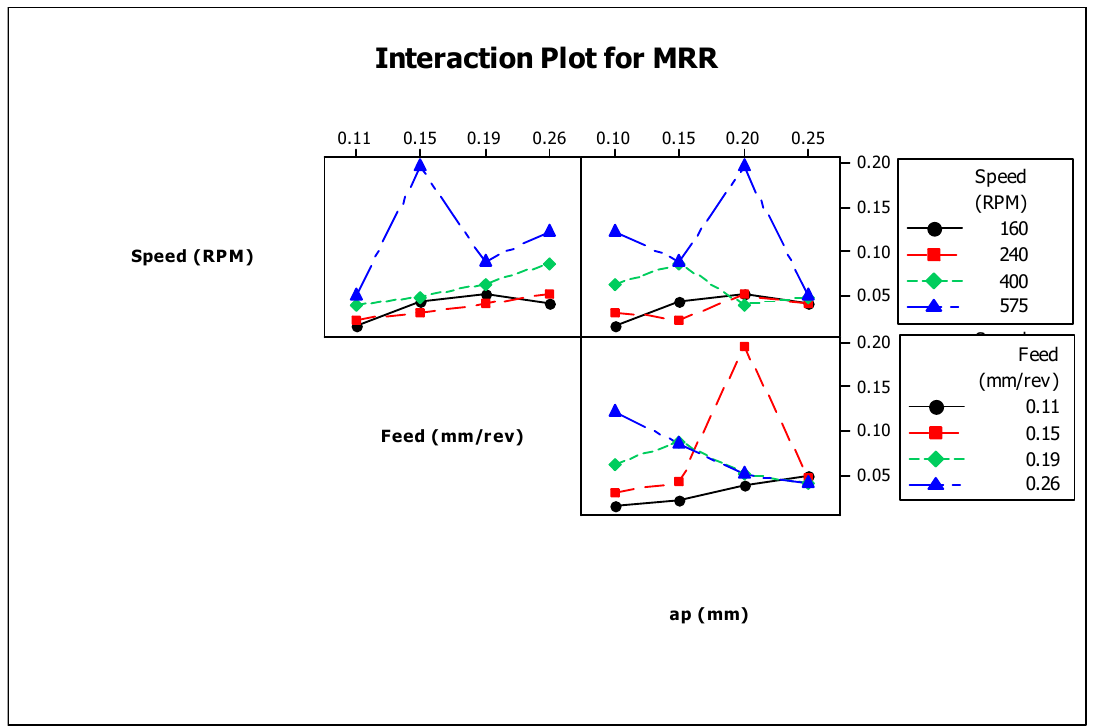
Figure 2. Interaction plot for material removal rate (MRR).